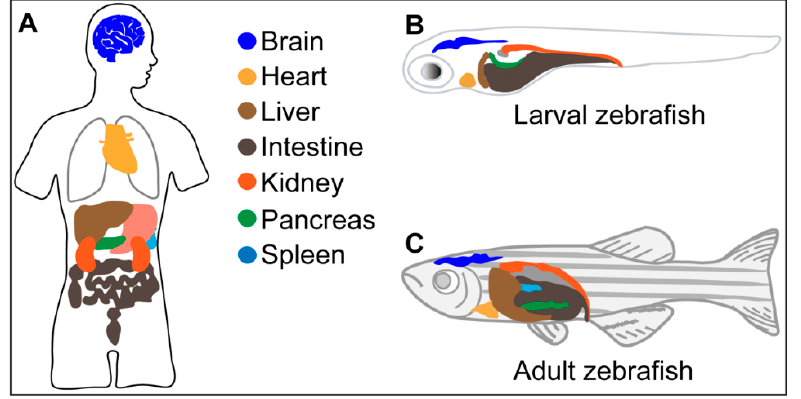
Figure 1. Corresponding organs and tissues in humans ( A ), and larval ( B ) and adult ( C ) zebrafish.